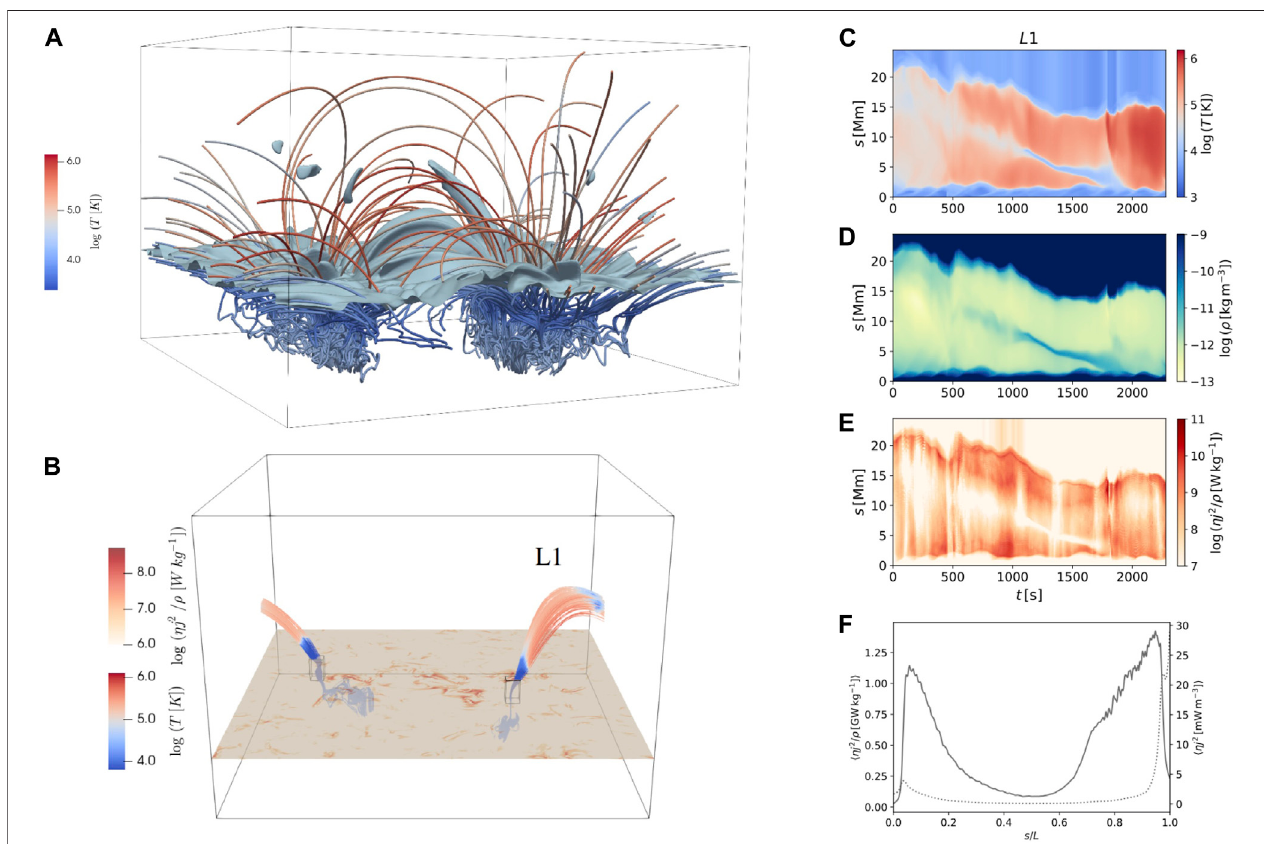
FIGURE13| Self-consistentcoronalrainformationina3DRMHDsimulationwith Bifrost ,byKohutovaetal.(2020)(Figures1,3,4,7reproducedwithpermission© ESO). (A) 3D con fi guration of the simulation domain (24 × 24 × 16.8 Mm), visualising magnetic fi eld lines. The colour denotes the temperature. The 5 × 10 – 12 kg m − 3 density isosurface is shown in blue. Several cool and dense condensations can be seen in the c orona. (B) A snapshot of selected magnetic fi eld lines crossing a condensation in a loop marked L1. The colour denotes the temperature. The surface at z = 1.2 Mm shows concentrations of strong Joule heating in the chromosphere. The loop footpoints are outlined by a black surface. Top 3-panel on the right: (C – E) Evolution of temperature, density and Joule heating per unit mass along a selected fi eld line of loop L1 crossing the condensation. (F) Time-averaged Joule heating per unit mass (solid) and volumetric heating (dotted) along loop L1, normalised by loop length. See Kohutova et al. (2020) for further